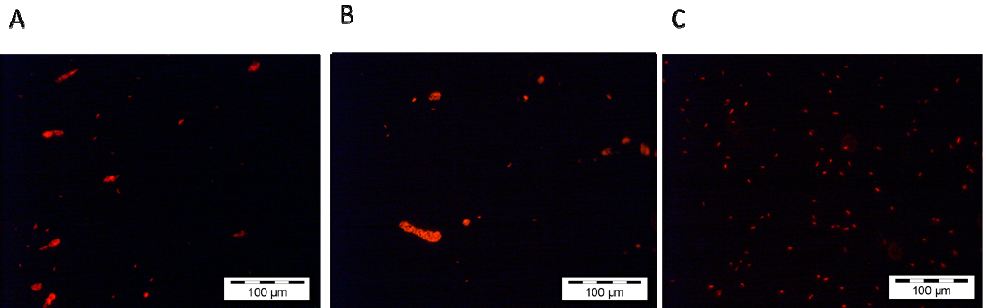
Figure 4. Documentation of clump formation in the water habitat on day 3 in presence of ( A ) C. roenbergensis , ( B ) V. anglica , and ( C ) absence of clumps in the control treatment. Pictures were taken with a Leica epifluorescence microscope at 40× magnification. The red depicts the fluorescence of the DSRed protein.